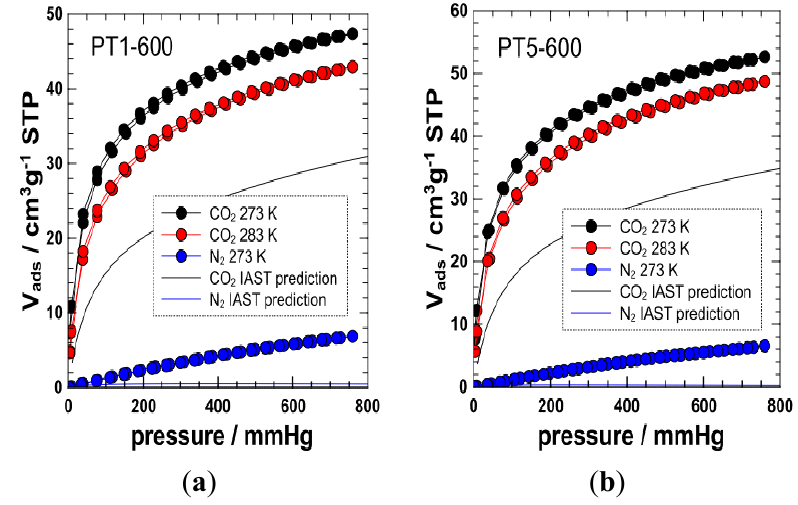
(273 K, 283K) 2 /N 2 2